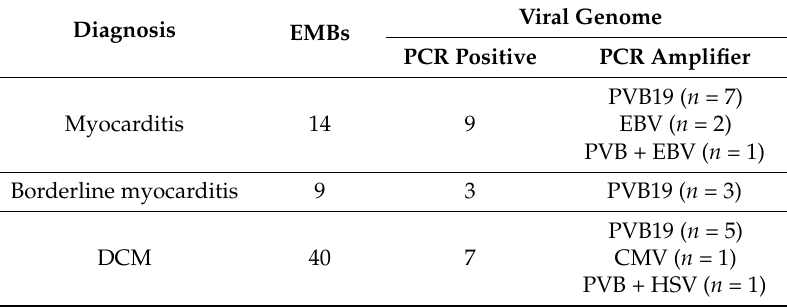
Table 2. Polymerase chain reaction (PCR) results: viral DNA genome amplified. Viral Genome Diagnosis EMBs PCR Positive PCR Amplifier Myocarditis 14